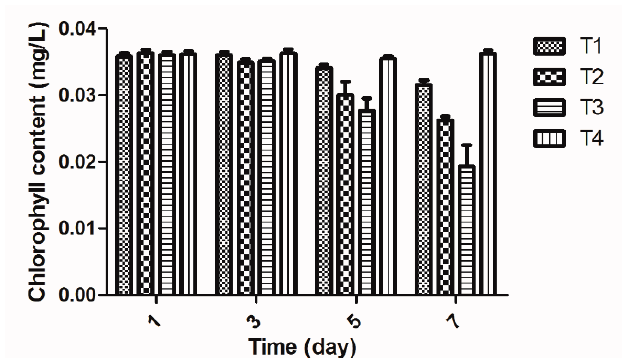
Figure 3. The changes of chlorophyll content in rice (The data presented are the mean ± SD). T1 : Xoo + Compound 2-(methylsulfonyl)-5-(4-fluorophenyl)-1,3,4-oxadiazole; T2 : Xoo + Bismerthiazole; T3 : Xoo ; T4 : Untreated blank control.